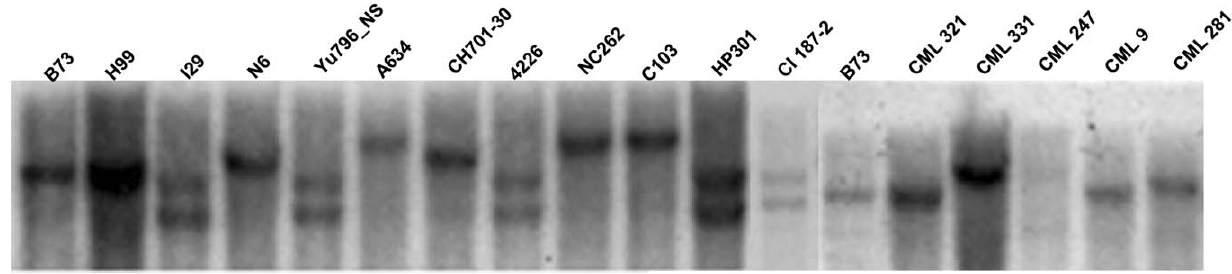
Figure 3. Southern blot of lines that did not PCR amplify for ZmLOX5 . B73, confirmed to have a functioning ZmLOX5, is used as a control for the Southern blot. Five of the inbred lines screened show double banding: Yu796_NS, 4226, I29, HP301 and CI 187-2 and are suspected to have two copies of ZmLOX5 . One is also missing a band: CML 247, and is suspected to have no copy of ZmLOX5 .